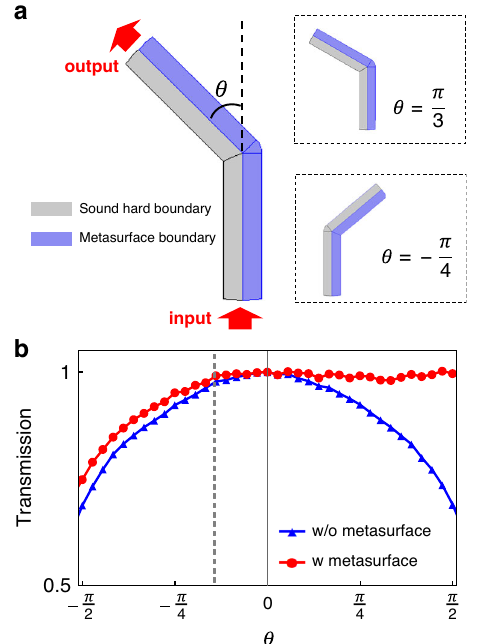
Fig. 4 Bending effects on the acoustic spin transport. a The bended metasurface waveguide with the bending angle θ . Two bending cases are shown for clarifying bending structures with a corner defect. The sound hard boundaries and ideal metasurface boundaries with the re fl ection phase π , are denoted as the gray and blue color, respectively. b The transmissions of the metasurface waveguide (red dotted line) and the conventional circular duct waveguide (blue dotted line) as the function of the bending angle θ . The side bar structures of metasurfaces will have volume overlaps when θ < − 0.14 π (gray dashed line). The demonstration frequency is 2.9 kHz.